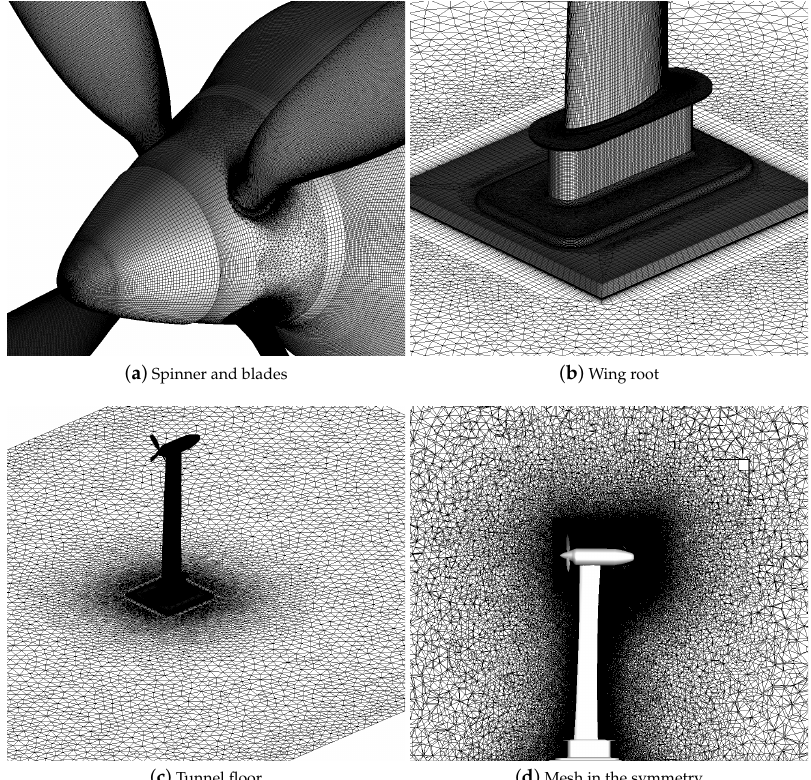
Figure 4. Computational grids for Kestrel-RANS simulations.